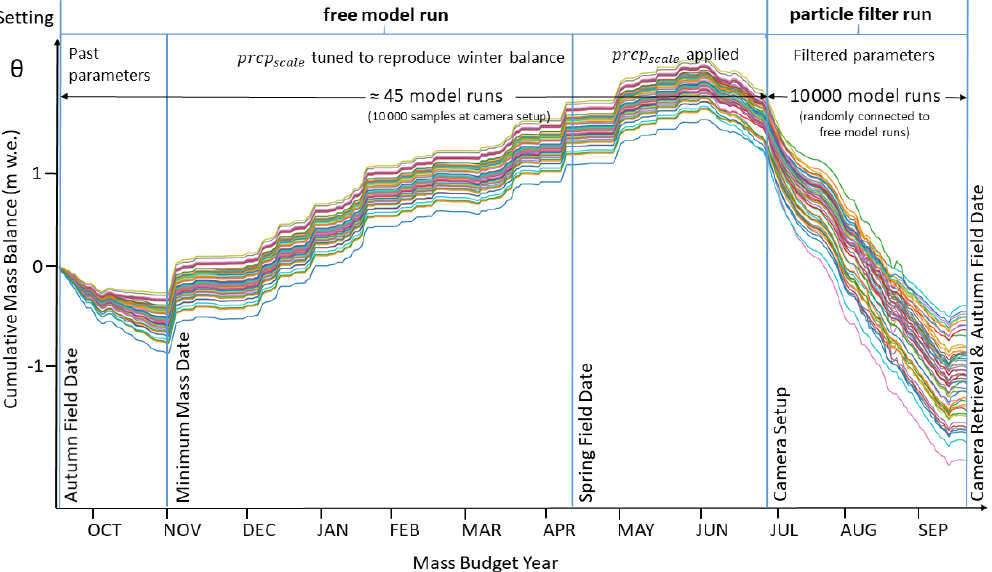
Figure 10. Schematic model and parameter settings on Rhonegletscher during the mass budget year 2019. After an initial phase with parameters from past calibration, the precipitation correction factor prcp scale is tuned to match the winter mass balance. When the first camera is set up, we sample the existing model runs 10000 times to be able to couple the free model runs with the 10000 particles during the particle filter period (not all are drawn for